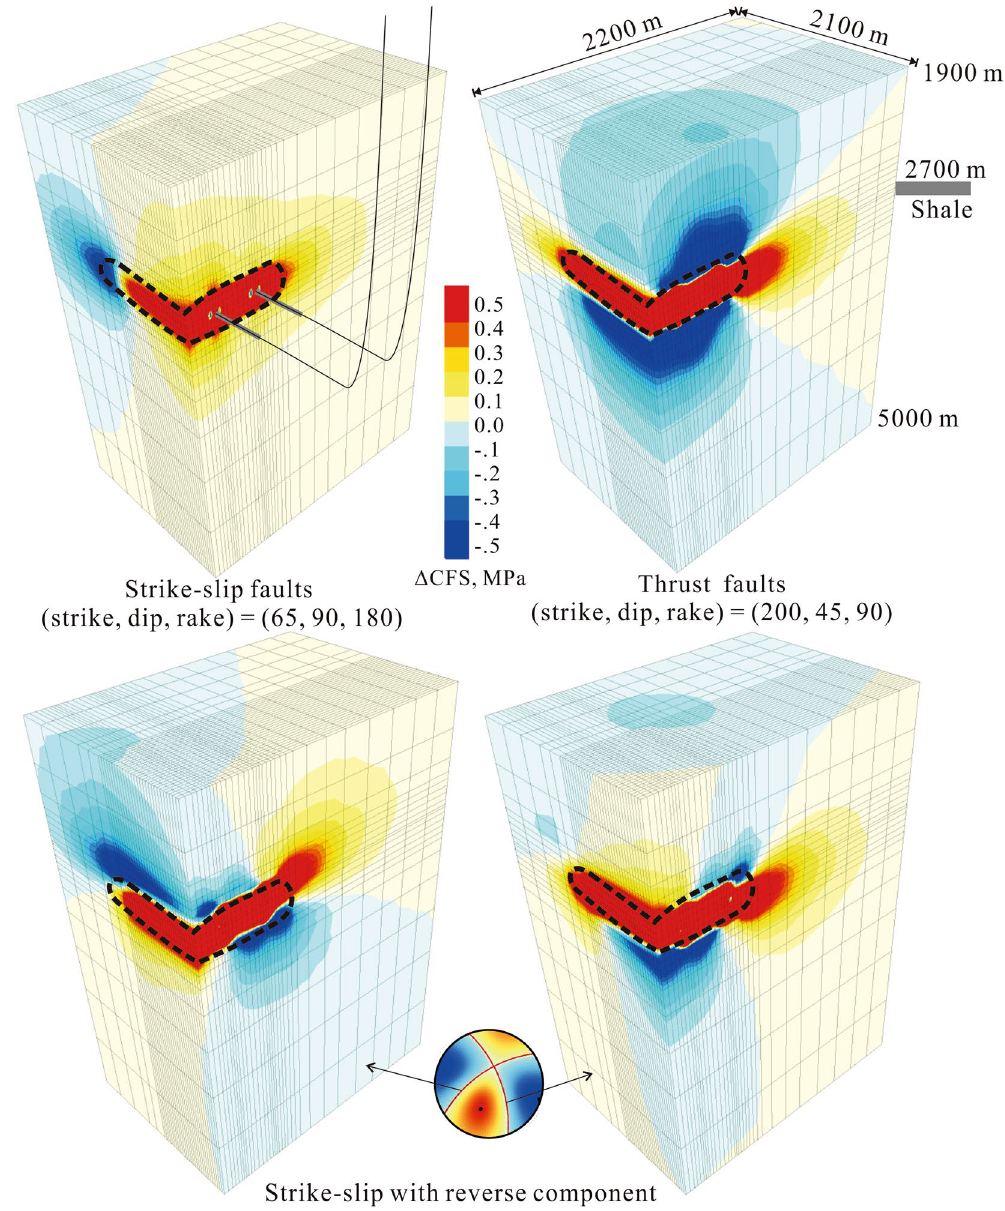
Figure 7. Estimated distributions of Δ CFS on favorably oriented strike-slip and thrust faults, and specified faults after 10-stage zipper fracturing in two wells. The dashed lines mark regions in which pore pressure and the total Δ CFS increased